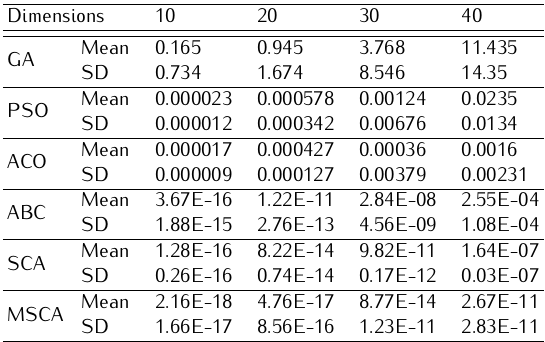
Table A.6. The results of GA, PSO, ACO, ABC, SCA and MSCA for Non-continuous Rastrigin function.